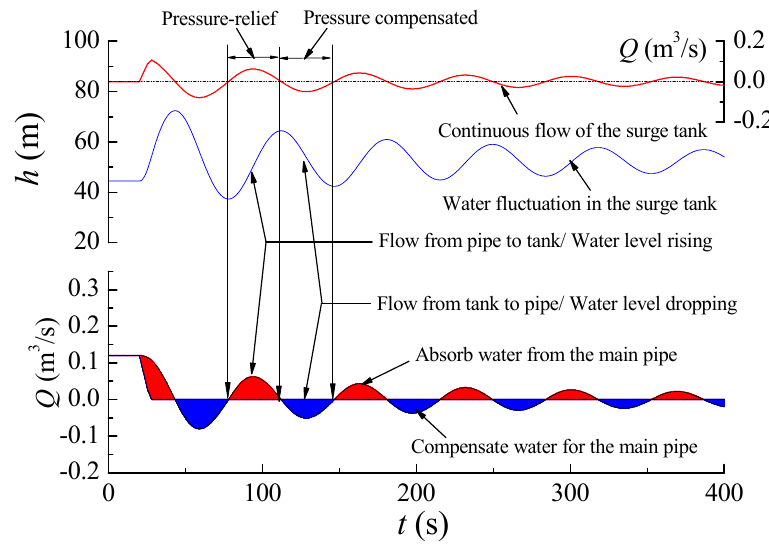
Figure 8. Response principle of the regular surge tank.